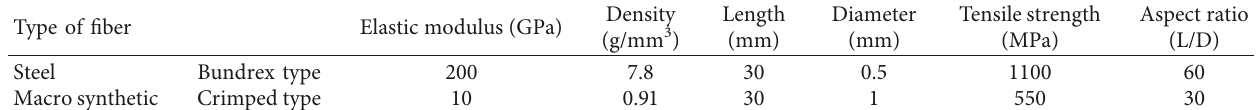
Table 4: Properties of fibers [34, 36].